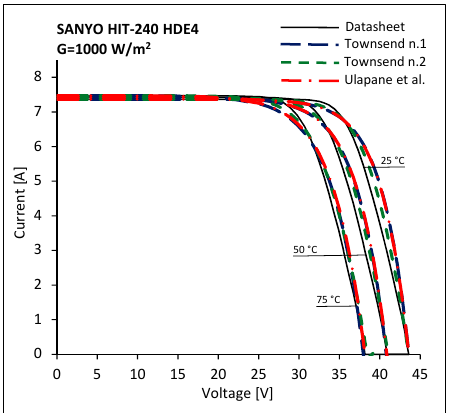
Figure 14. Comparison between the issued I-V characteristics of the Sanyo HIT-240 HDE4 at G = 1000 W/m 2 and the characteristics calculated by means of the Townsend n.1, the Townsend n.2 and the Ulapane et al. models.